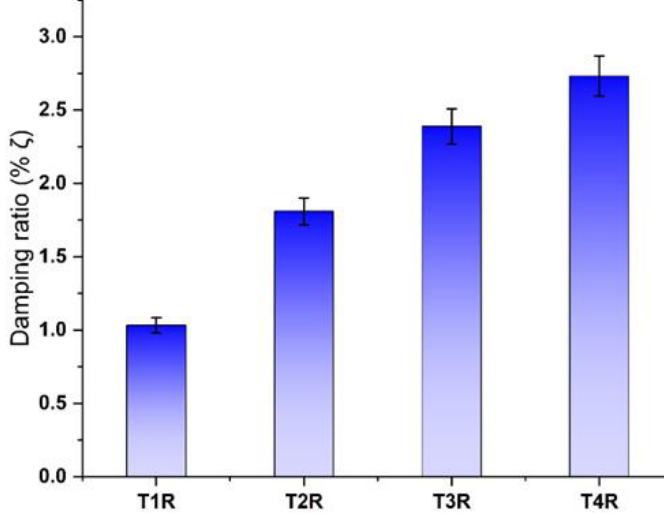
Figure 5. The damping ratio response of the samples without a coat. By adding a ceramic coating, it has been observed that there are slight differences in dynamic damping performance values for specimens T2C, T3C, and T4C at 2.56, 2.03, and 2.23, respectively (shown in Figure 6).